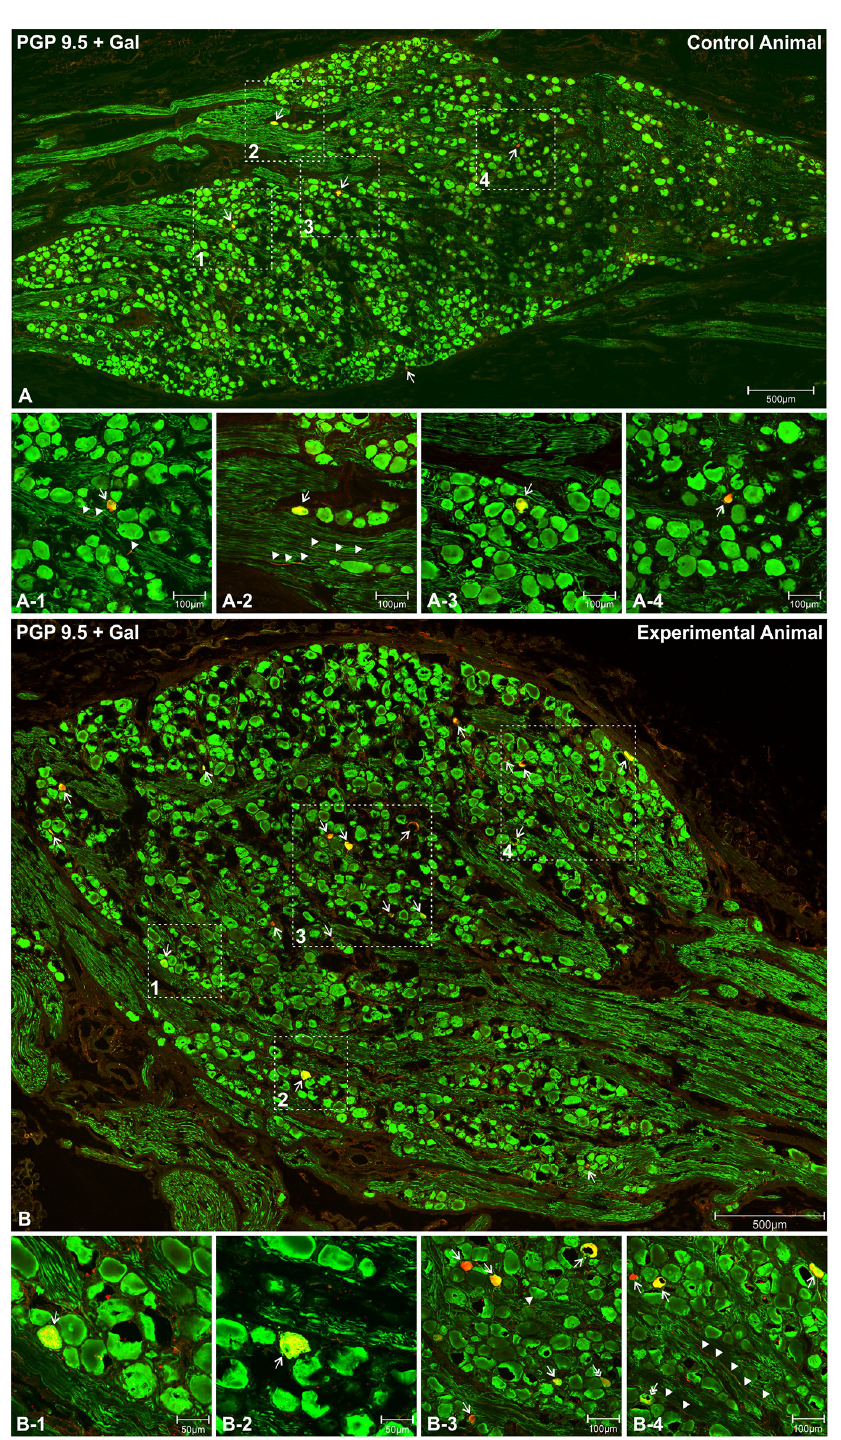
Fig 3. Characteristics (shapes, immunofluorescence) of PGP9.5/Gal-immunofluorescent vagal nodose perikarya occasionally observed in the control and experimental animals. Microphotographs showing high magnifications of occasionally observed Gal-immunoreactive neurons (arrows) with large ( A-1, A-3, A-3, C-1, C-2, C-3 ) and small ( B-1, B-3, B-3, D-1, D-2, D-3 ) cell body sizes occurring in the vagal nodose ganglia in the control ( A-1, A-3, A-3, B-1, B-3, B-3 ) and experimental ( C-1, C-2, C-3, D-1, D-2, D-3 ) animals. A characteristic, clump-like Gal-immunofluorescence pattern is visible in some of the perikarya ( A-1, A-3, A-3, C-1, C-2, C-3, D-1, D-2, D-3 ), while others are characterized by strong, evenly dispersed immunofluorescence ( B-1, B-3, B-3 ). Cell dimensions and scale bars are marked in the pictures.